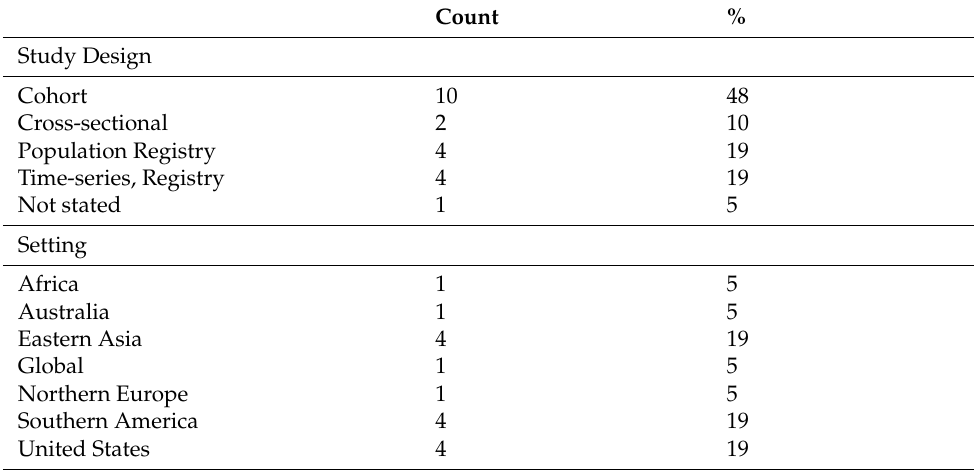
Table 4. Birthweight Study Characteristics n =